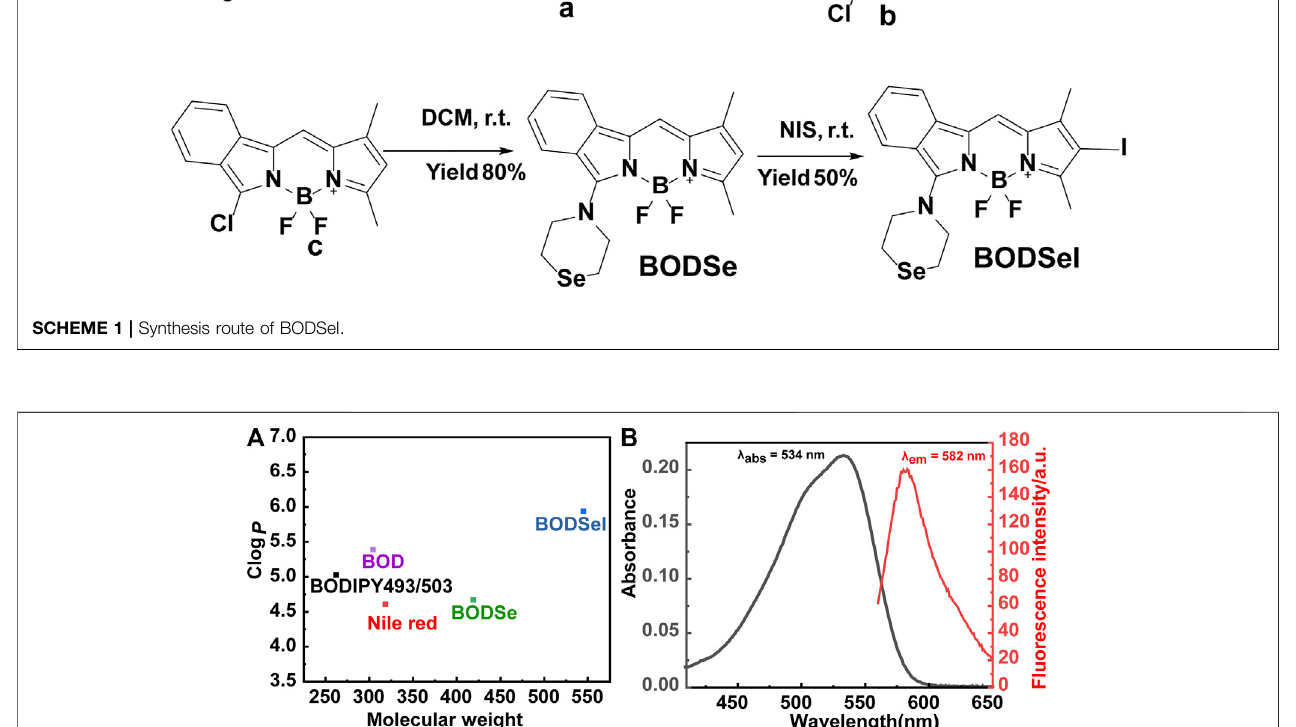
FIGURE 2 | (A) Comparison of the molecular weight and Clog P of BODSeI, BOD, BODSe, Nile red, and BODIPY493/503. (B) Absorption and fl uorescence spectra of BODSeI (1 μ M) in DCM. Exicted at 535 nm, slits: 2.5/2.5 nm.